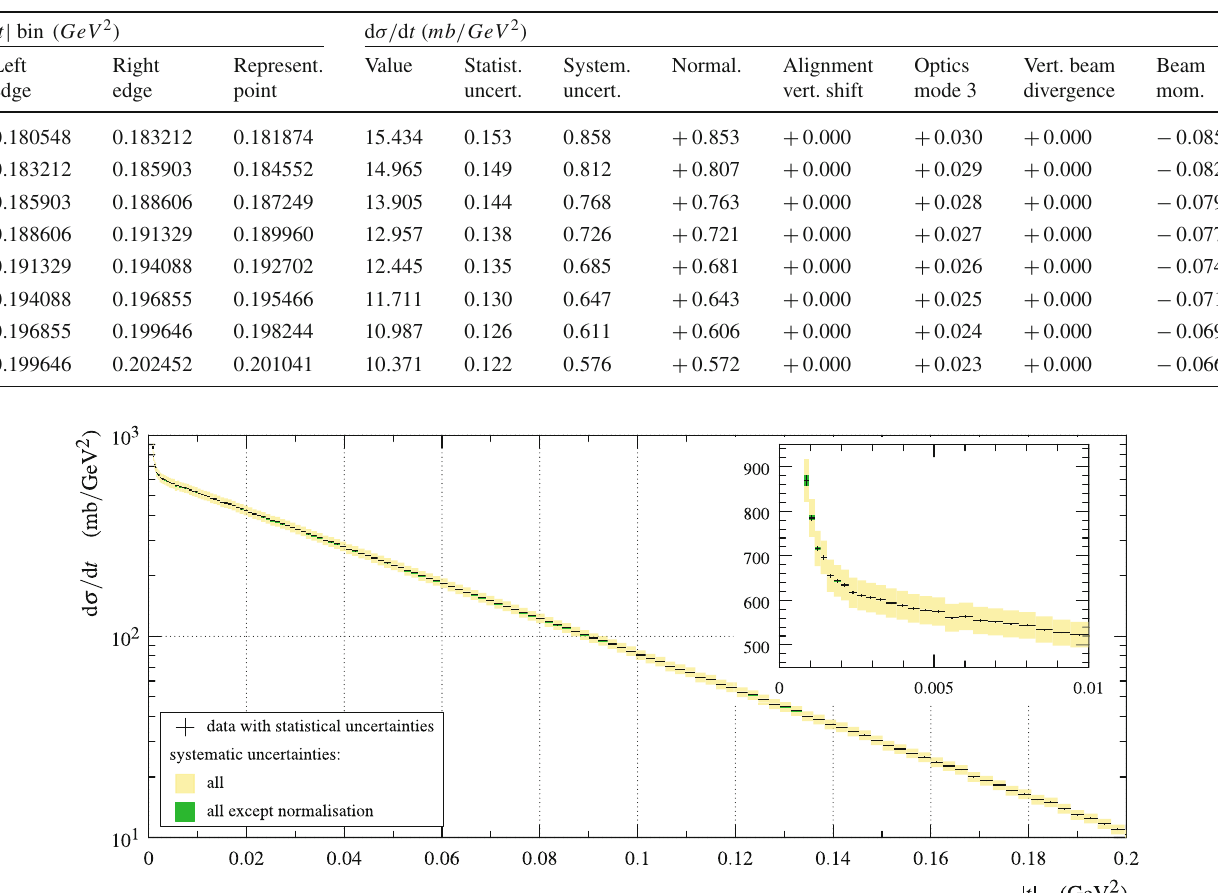
arecentredaroundthebincontent.Inset:alow- | t | zoomofcross-section rise due to the Coulomb interaction